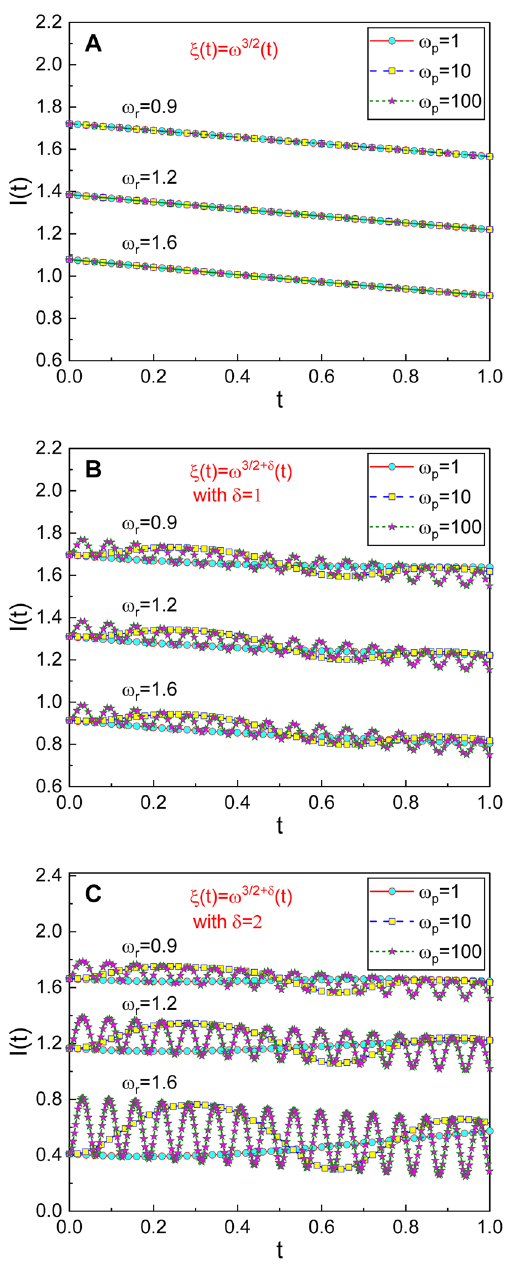
Figure 4. Graphical demonstration for optimal adiabatic condition from temporal evolution of I ( t ). Each panel is drawn for several different values of ω p and ω r . ξ( t ) = ξ 0 ω 3 / 2 + δ ( t ) has been taken regarding Eq. (7), where δ is a deviation from the optimal condition. Panel ( A ) is for δ = 0 , ( B ) for δ = 1 , and ( C ) for δ = 2 . The values of parameters that we have taken are ǫ = 0.5 , β = 0.5 , Q = 10 , ξ 0 = 0.4 , E ( 0 ) = 2 , and C = 1 . ( A ) shows that I ( t ) does not vary locally when ξ( t ) follows the condition in Eq. (7). If ξ( t ) deviates from that condition, the fluctuation of I ( t ) emerges ( B , C